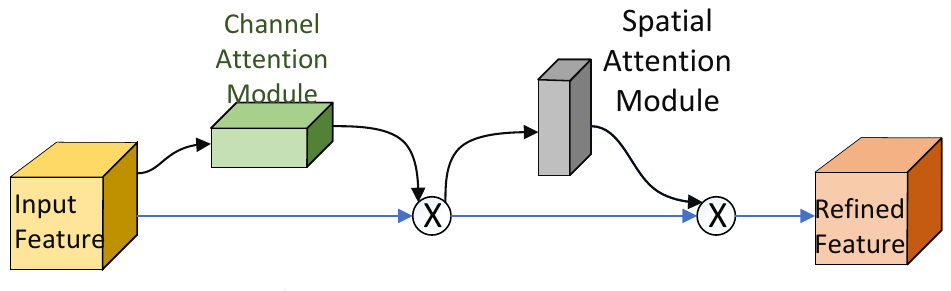
Figure 3. CBAM structure